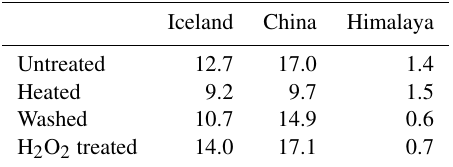
Table 4. BET surface area (m 2 g − 1 ) of all untreated and treated